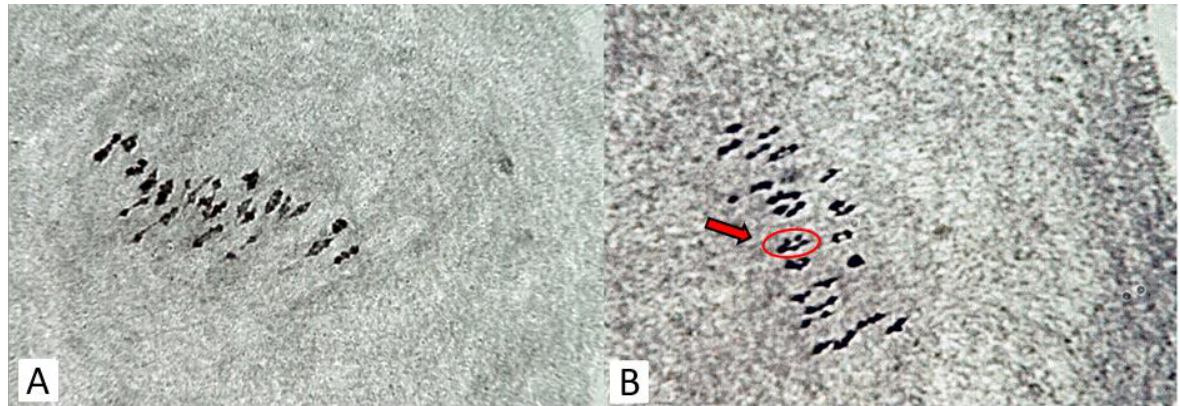
Figure 4. Chromosome conjugation at metaphase I of meiosis in cotton G. hirsutum : ( A ) photoperiod- sensitive wild-type G. hirsutum subsp. purpurascens (var. El-Salvador)—26 II ; ( B ) day-neutral mutant line (var. Kupaysin)—24 II + 1 IV . Arrow indicates a quadrivalent.